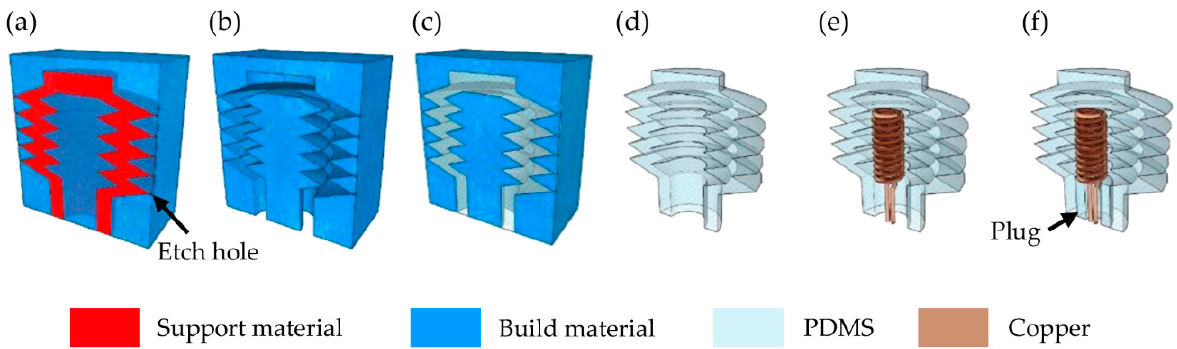
Figure 2. Fabrication process of cross-sectional thermopneumatic bellows actuator. ( a ) The actuator was printed through a 3D printer as a mold composed of build and support material. ( b ) Support material was dissolved through etch holes placed around the edge. ( c ) Polydimethylsiloxane prepolymer was poured and cured after vacuum. ( d ) PDMS bellows actuator after dissolving the mold. ( e ) 3D coil heater implanted inside the bellows actuator. ( f ) A thermopneumatic actuator after sealing with the PDMS